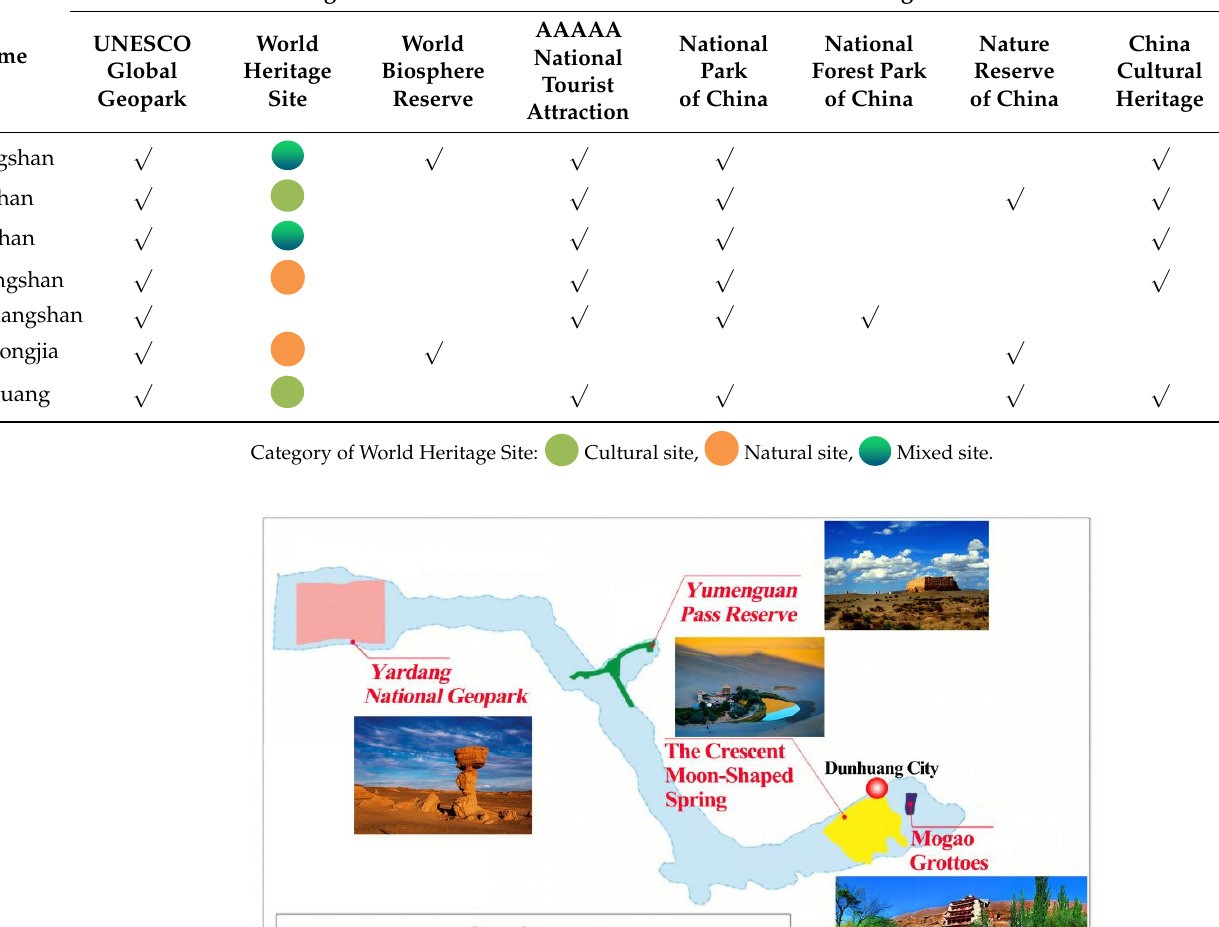
Figure 10. The Dunhuang UGGp overlaps with many other brands (modified from [105]).